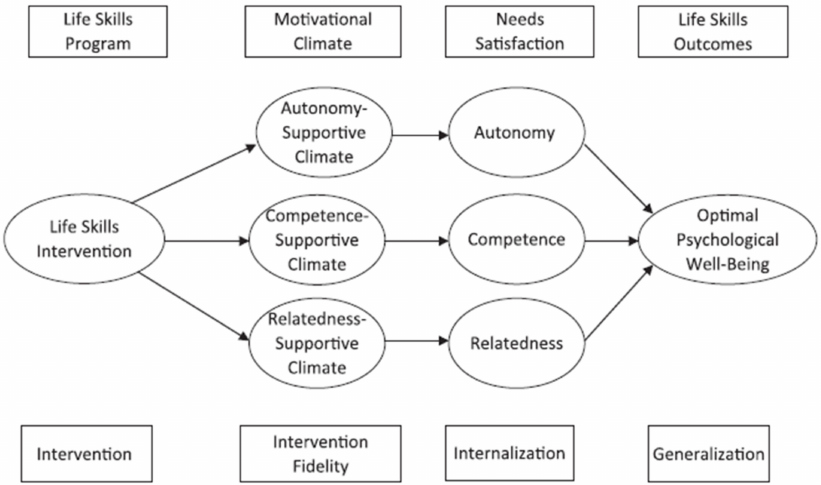
Figure 1. Conceptual model of life skills development (Hodge et al.